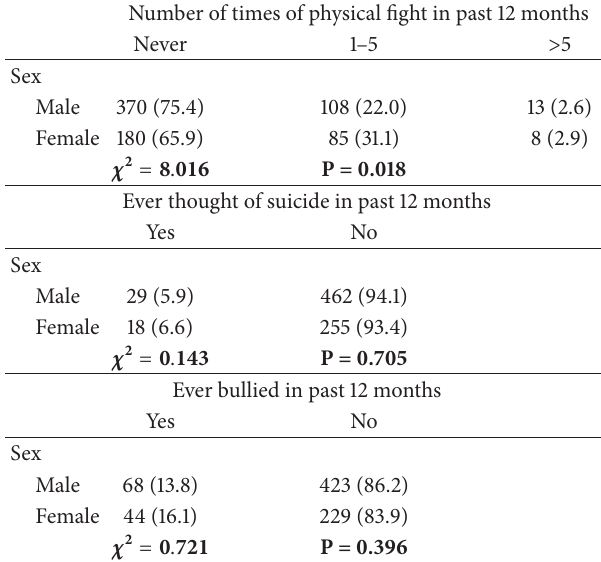
Table 7: Associations of sex with specific manifestation of behav- ioral problems.